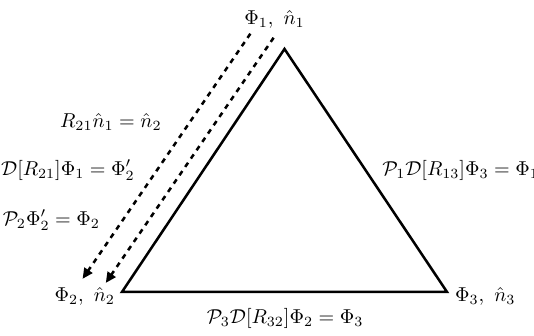
which in general differs 2